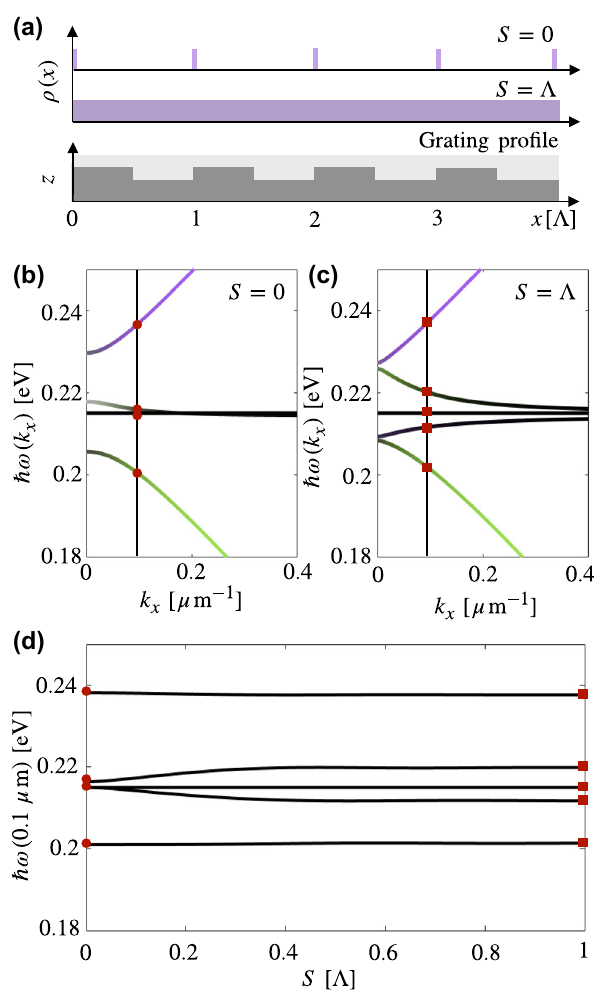
Figure 4: Dependency of bands on molecular spatial distribution: (a) Molecular distribution with S = 0 , Λ ) compared to a grating with period Λ . (b) Dispersion relation with S = 0, displaying four bands, and the crossing of a polariton mode and the dark molecular modes. (c) Dispersion relation with S = Λ , displaying five bands and no = 0.1 μ m for varying S . For band crossings. (d) Eigenvalues at k x S > 0 the crossing point of the middle polariton mode and dark molecular resonances becomes an avoided crossing, resulting in a molecule-like) mode, and so the four bands split into five